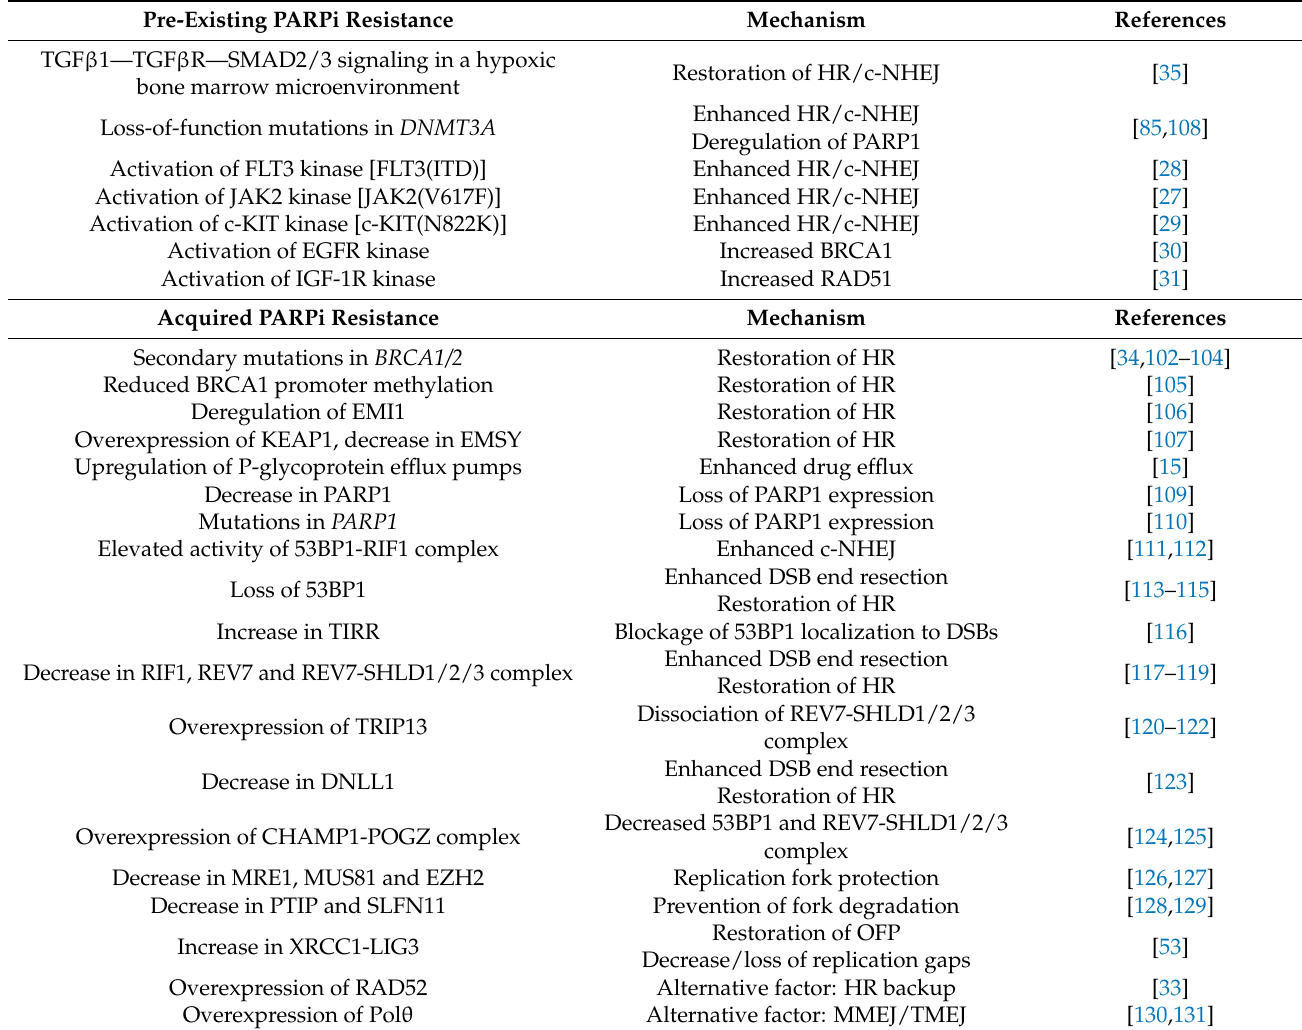
Table 3. Mechanisms of pre-existing and acquired resistance to